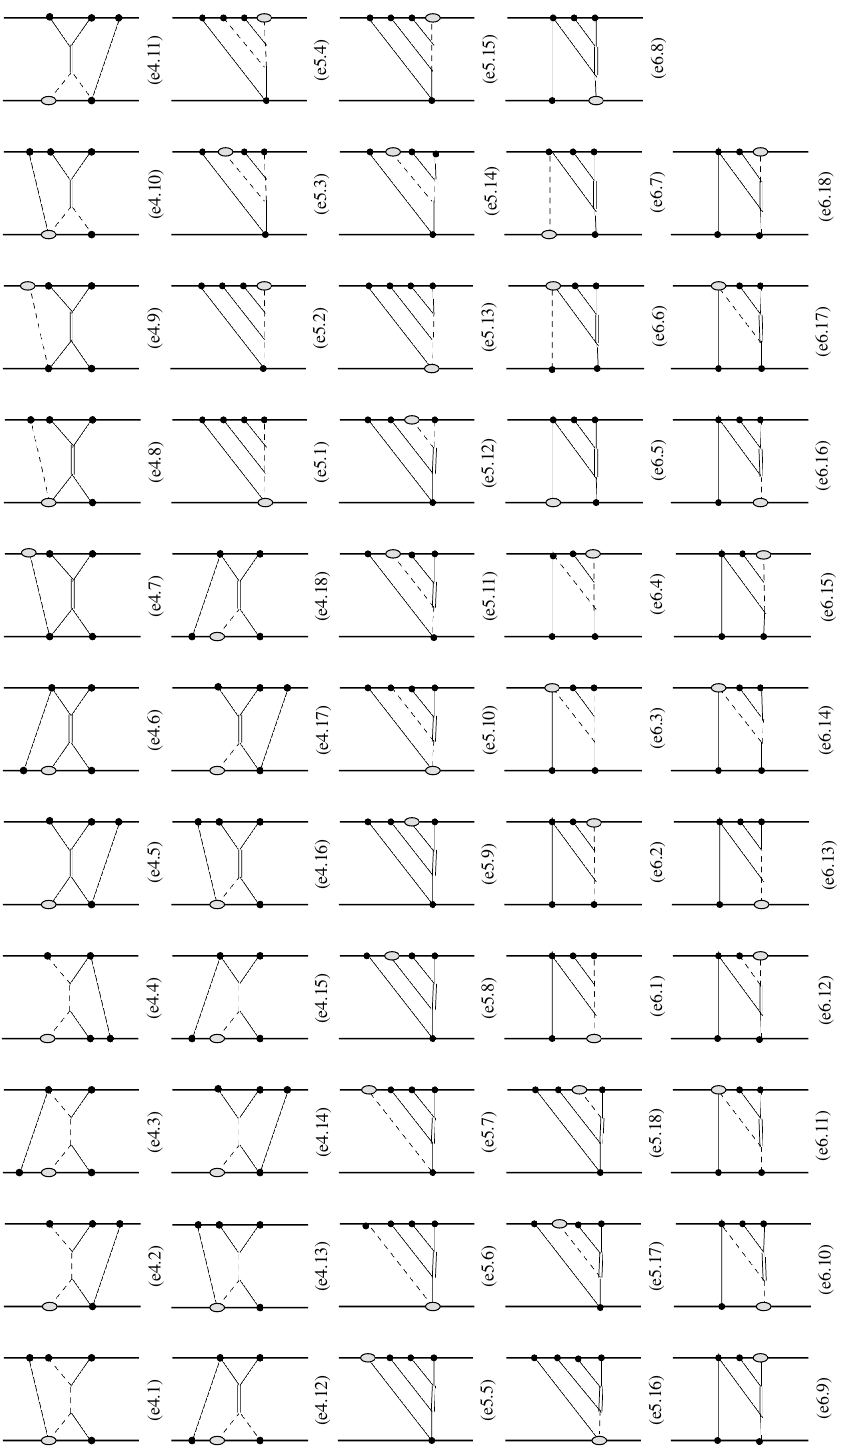
Figure 7 . Feynman graphs which contribute to the N 3 LO spin-orbit coupling at G 4 . This figure contains all graphs with topologies (e4)-(e6) of figure